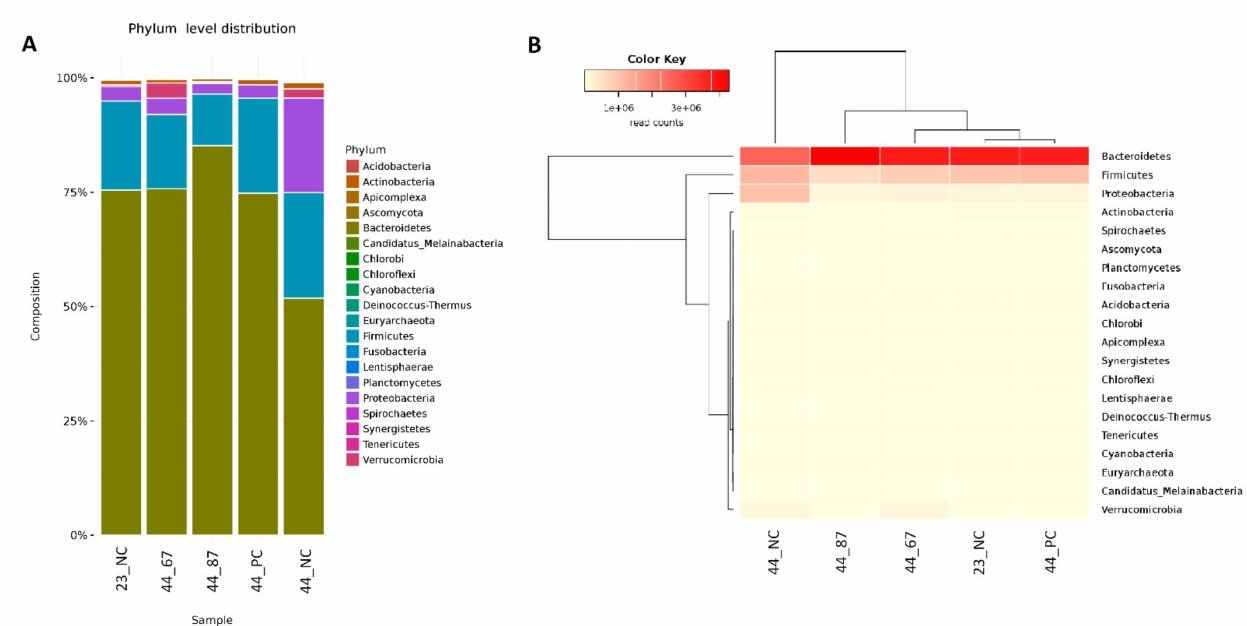
Figure 1. ( A ) The abundance of phyla and their relationships across the samples. ( B ) Dendrograms determined by computing hierarchical clustering from the abundance levels, showing the relationship between the phyla (left) and the samples (top). The abundance levels (number of reads associated with each taxa) were logarithmically transformed to base 2 for